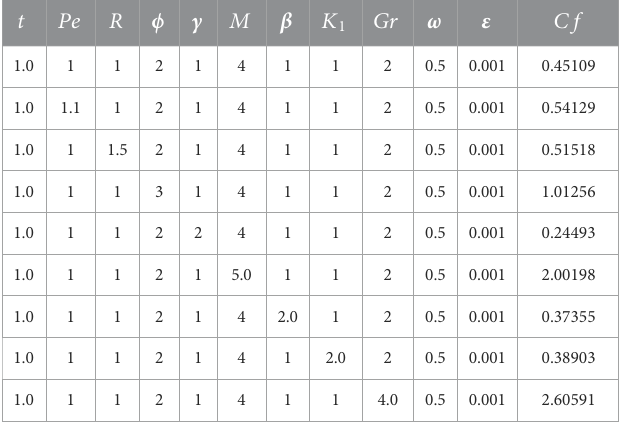
TABLE 2 Effect of different parameters on skin